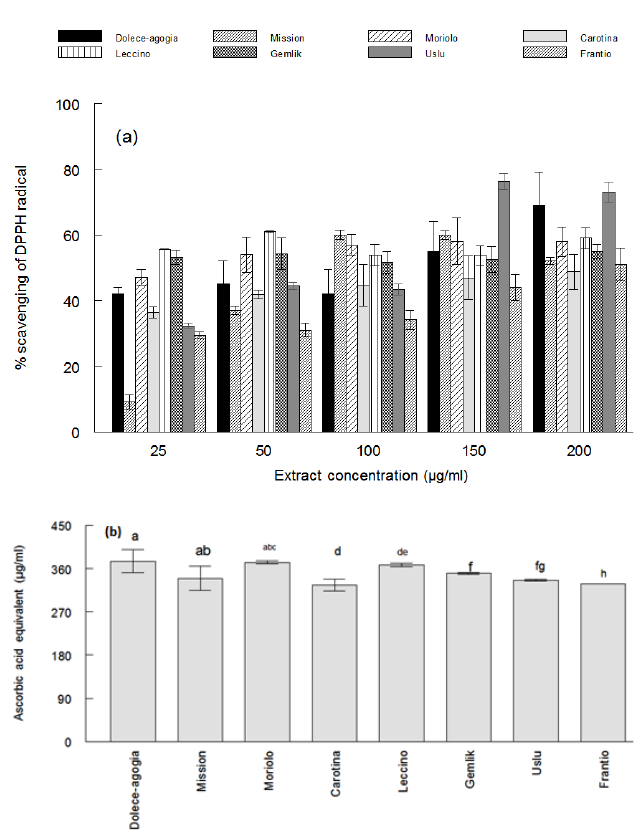
Fig. 2: Antioxidant activities of olive cultivars (a). DPPH radical scavenging activity of different cultivars of olive. values are means ± SD (n=3). (b). total antioxidant activity of different cultivars of olive at 100 µg/ ml measured by phosphomolybdenum reduction assay. Results are means ± SD (n=3).Values in figure followed by different letter are significantly (P < 0.05) different from control by DMR test.